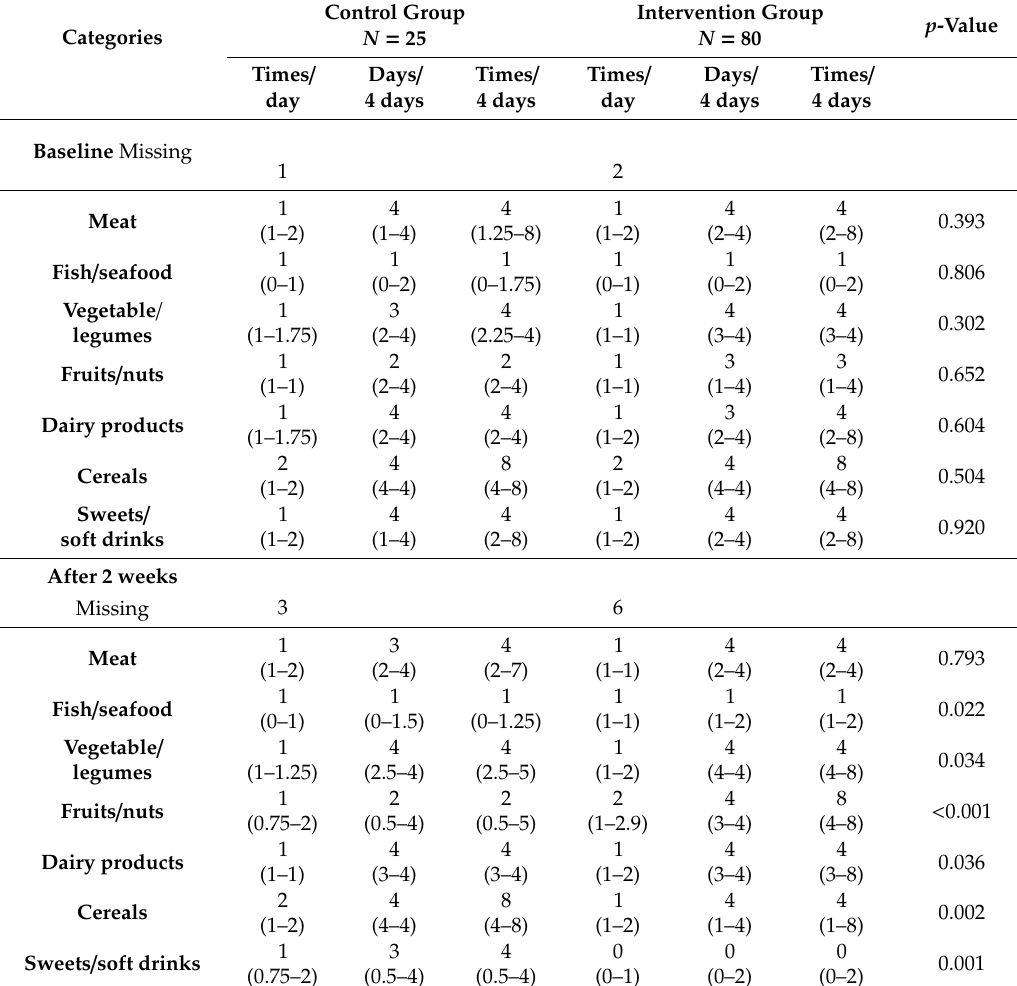
Table 5. The intake of di ff erent food items during run-in and after two